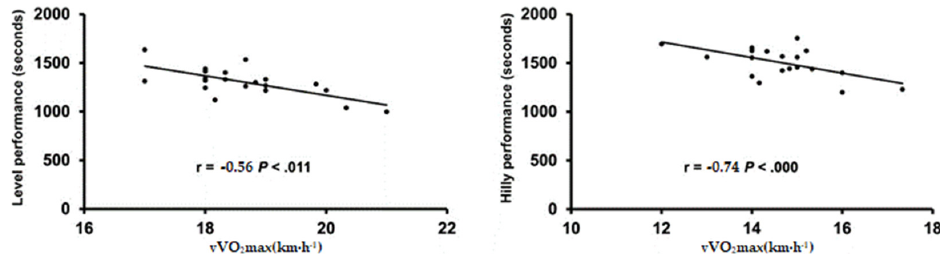
Figure 1. Correlation between level and hilly running performances and velocity associated with VO 2 max (vVO 2 max at level and uphill, respectively).